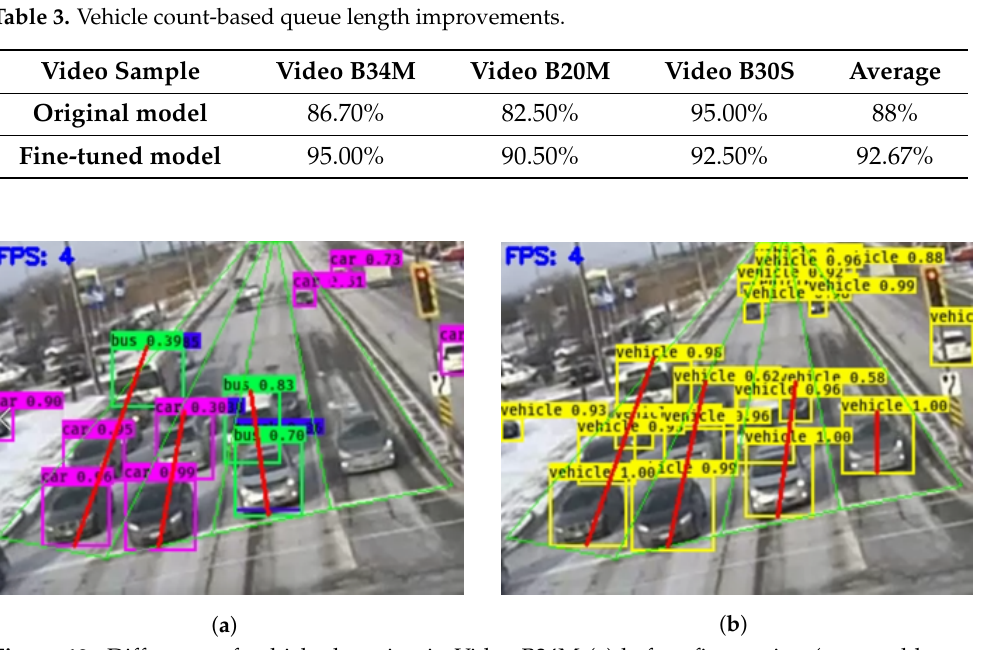
Figure 10. Difference of vehicle detection in Video B34M ( a ) before fine-tuning (cars and buses marked as purple and green colors respectively) ( b ) after fine-tuning (vehicles marked as